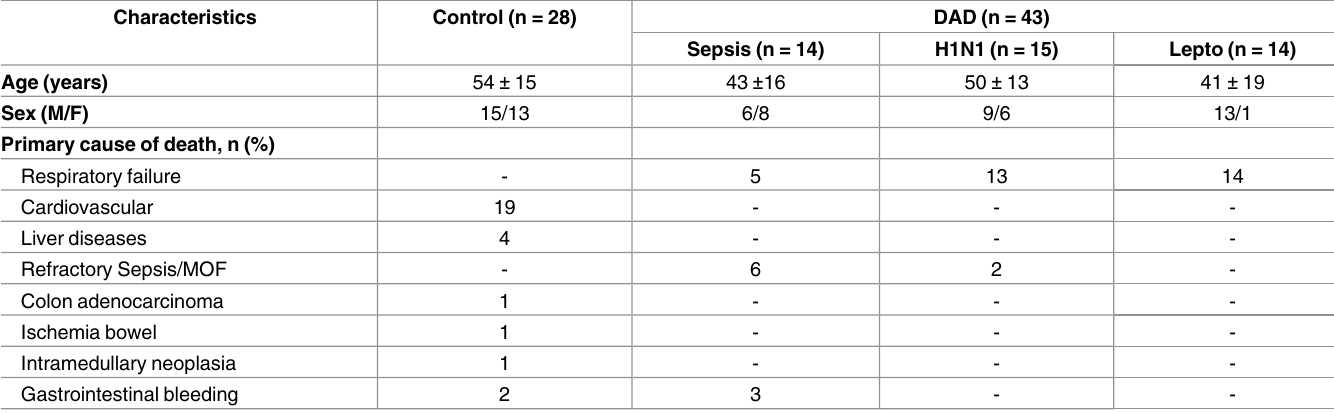
Table 2. Demographic and Clinical Data.